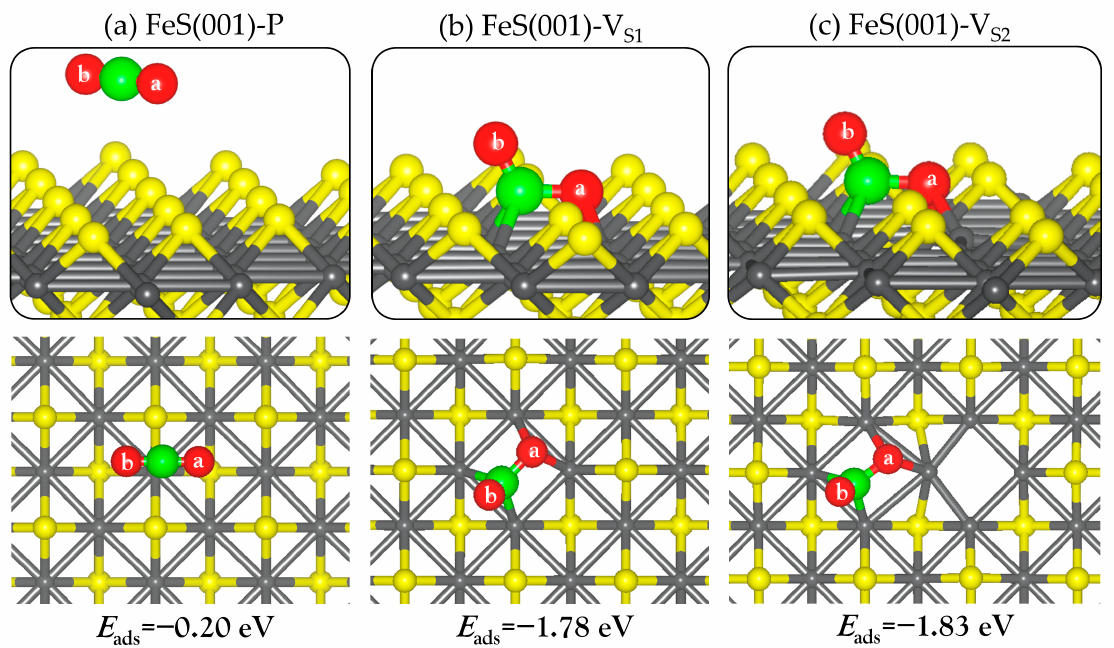
Figure 3. Lowest-energy adsorption structures of CO 2 on the perfect ( a ) and defective ( b , c ) FeS (001) surfaces with V S1 and V S2 . The inserts show the top views. (atomic colour: Fe = grey, S = yellow, C = green, O = red). Table 1. Adsorption energies, structure, charges, and vibrational frequencies of CO 2 on perfect and defective (V S1 and V S2 ) FeS